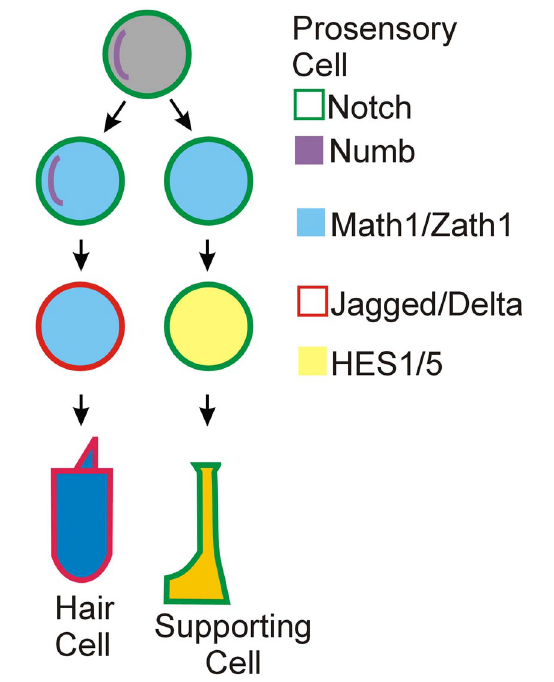
FIGURE 3. Summary diagram for the molecular signals that play a role in the determination of cells as hair cells. Initially, an epithelial cell divides to give rise to two prosensory daughter cells. During the final division, numb protein may become restricted to one of the two daughter cells, leading to a relative decrease in the level of Notch activation in that cell. Following terminal mitosis, each of the prosensory daughter cells begins to express an Ath1 protein. Next, the cell that will develop as a hair cell upregulates the expression of one or more Notch ligands, such as Jagged2 or Delta1. The factors that regulate ligand expression have not been determined, but asymmetrical localization of Numb could play a role. Expression of a Notch ligand leads to activation of Notch in adjacent cells. Activated Notch induces a downstream signaling pathway that results in the expression of the inhibitory bHLH proteins HES5 and/or HES1. Expression of HES proteins leads to inhibition and downregulation of Ath1. As a result, these cells are diverted from developing as hair cells and ultimately develop as supporting